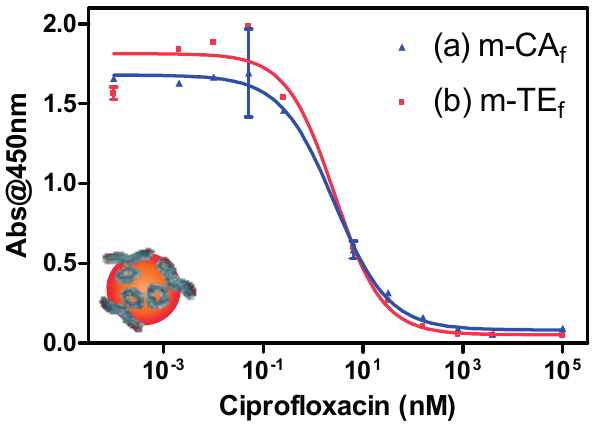
Figure 3. m-ELISA calibration curves of the different ELISA formats using the immunoreagents produced and the biomodified magnetic beads. ( a ) CA in red. Each point was the average of at least three-well replicates, and the assays were run on two different days.